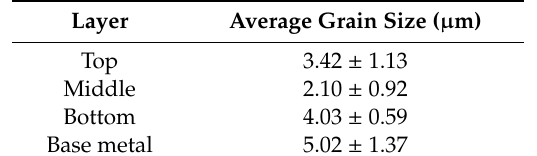
Table 3. Grain size (average) of the top, middle, and bottom layer of cladding and of the base metal.